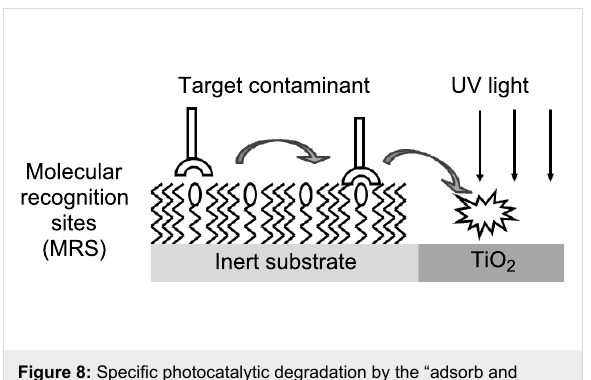
Figure 8: Specific photocatalytic degradation by the “adsorb and shuttle” approach (after [51]).